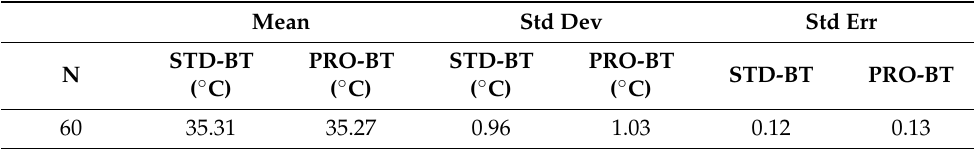
Table 3. The descriptive statistics of body temperature results.